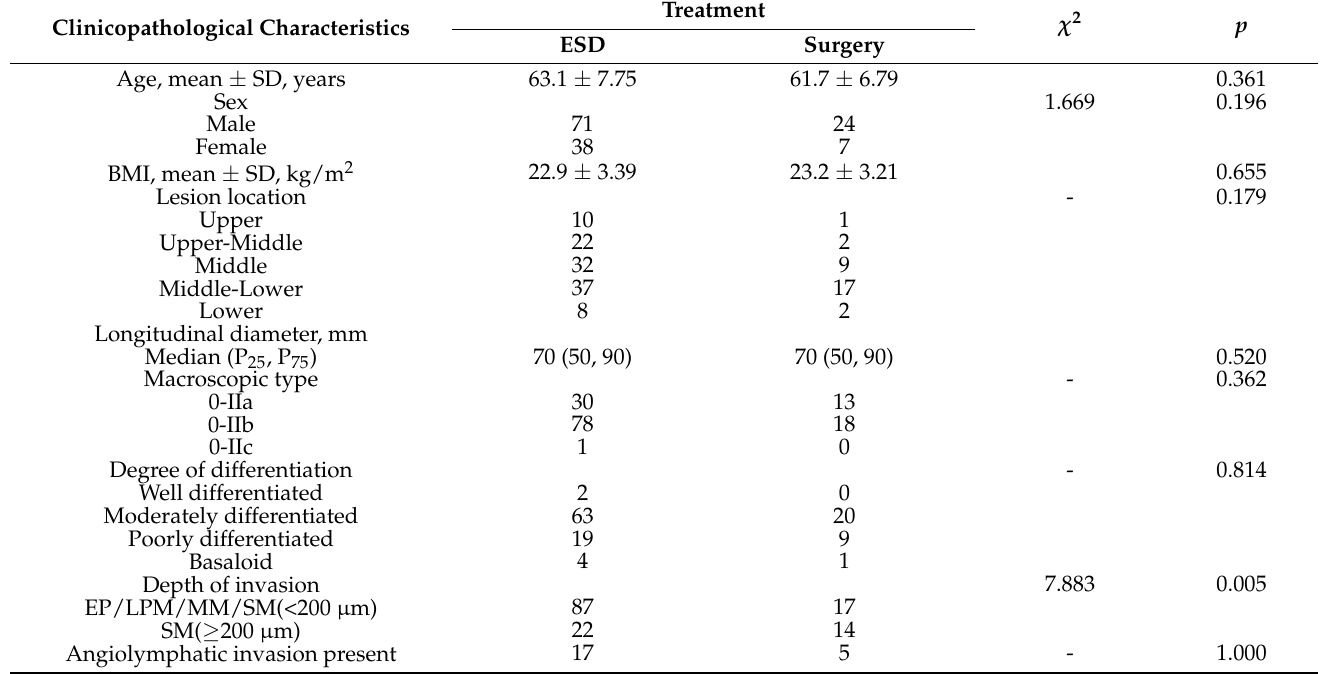
Table 3. Comparison of clinicopathological characteristics between the ESD and surgery groups.